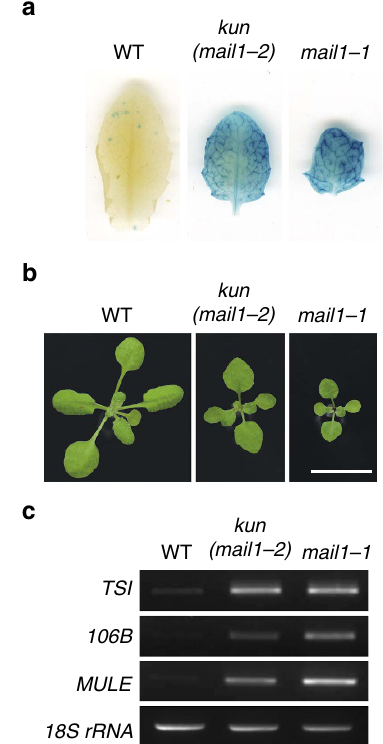
Figure 1 | mail1 mutations induce loss of silencing at the L5 locus and endogenous loci. ( a ) WT plants carrying the L5 transgene showed no glucuronidase activity, while the L5 locus was strongly reactivated in leaves of kun and mail1-1 mutants. ( b ) Photos of 3-week-old WT, kun ( mail1-2 ) and mail1-1 plants. Scale bar, 1cm. ( c ) RT–PCR analysis of transcripts from the TSI and 106B heterochromatic repeats and the AT2TE28020